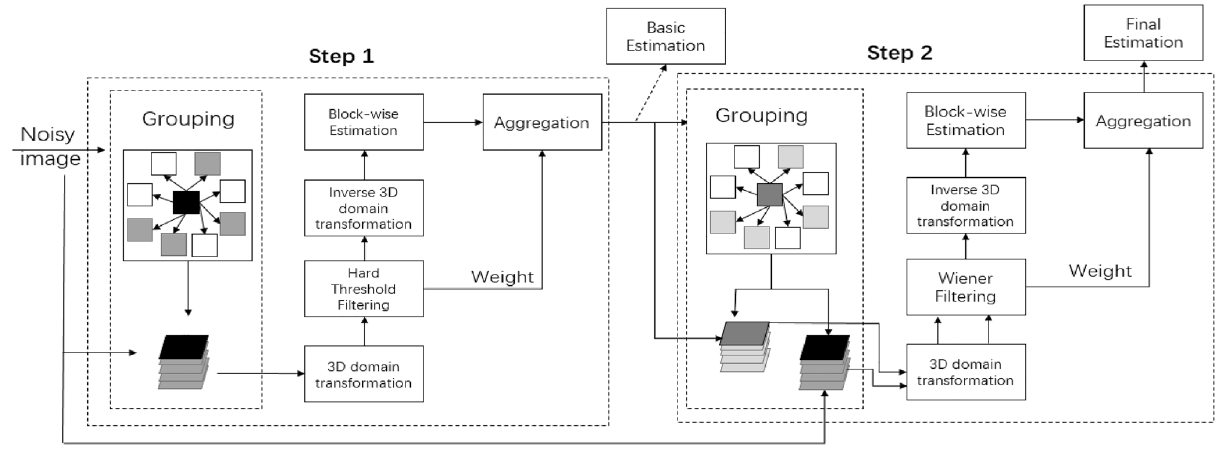
Figure 2. BM3D flow